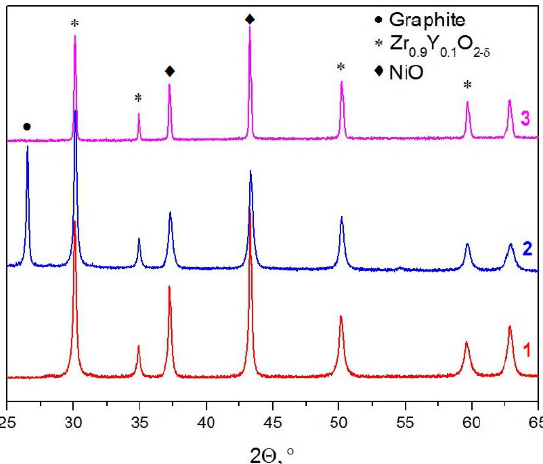
Figure 11. X-ray patterns of the initial NiO/YSZ composite (1), the printed sample with 20 wt.%